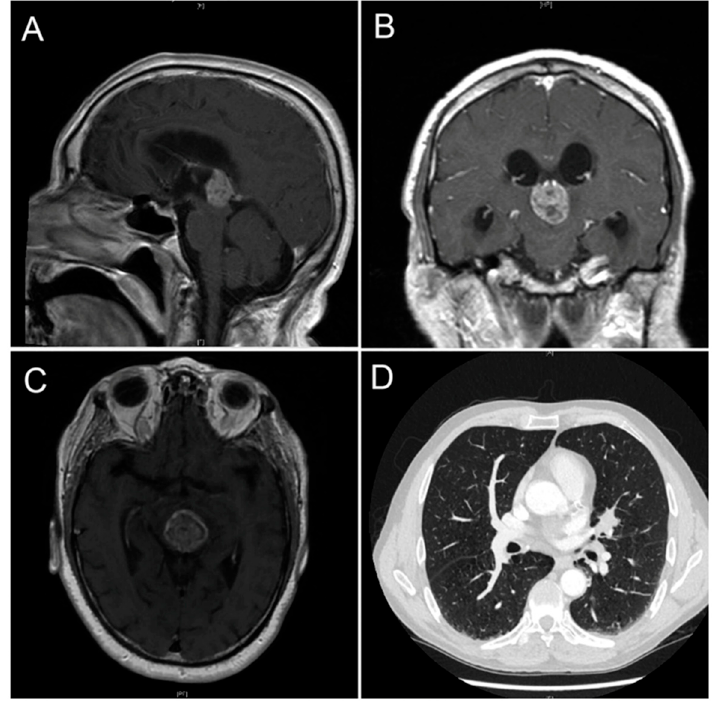
Figure 10. Pineal metastasis from lung adenocarcinoma. Brain MRI sagittal ( A ), coronal ( B ) and transverse ( C ) sections showing the pineal gland metastatic mass. Computed tomography showing a lung nodule over the left hilar region in the lower right corner ( D ). Image from Abdallah et al. (2020) [110]—Ochsner Journal.